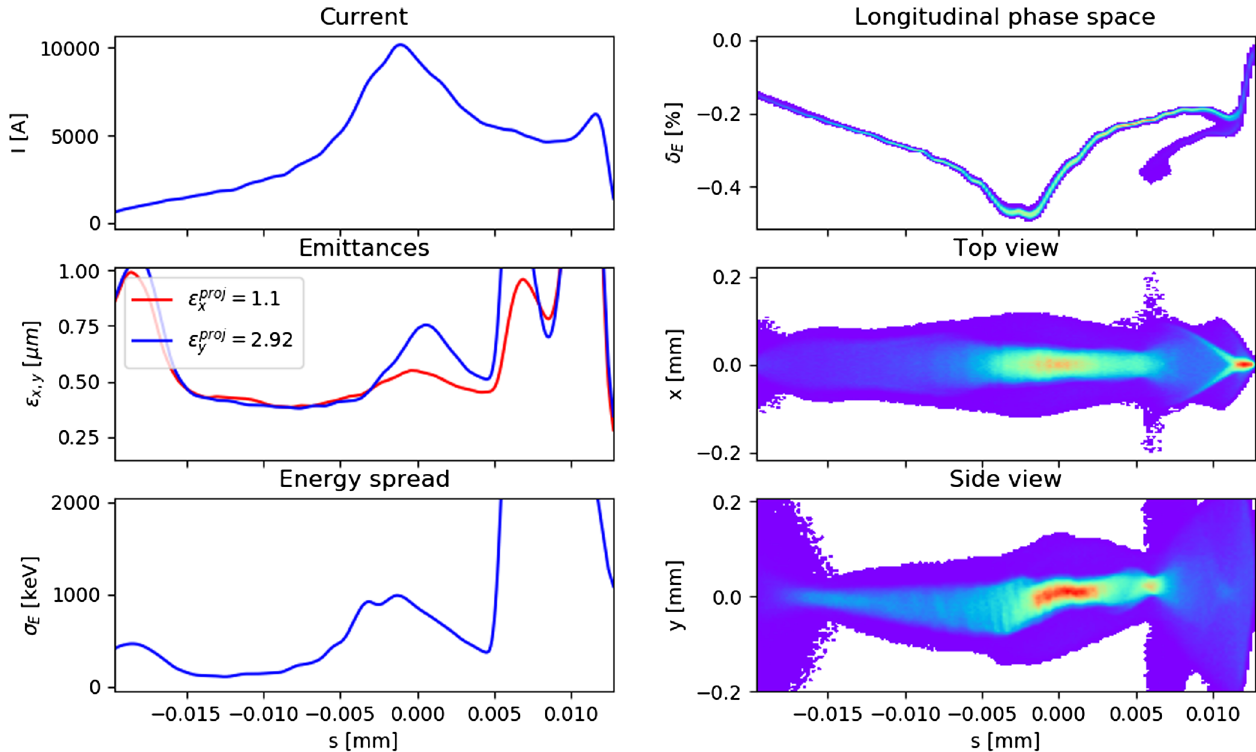
FIG. 9. The properties of the bunch with a charge of 500 pC compressed to 10 kA peak current at the SASE1 line